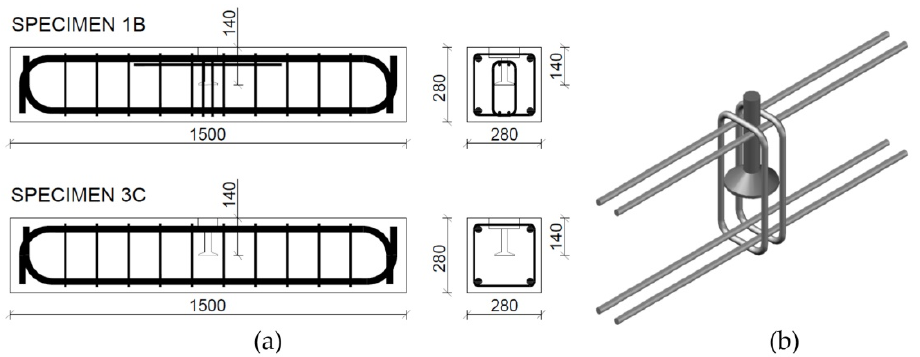
Figure 3. Reinforcement scheme of experimentally tested specimens: ( a ) global reinforcement of specimens; ( b ) detail of supplementary reinforcement.